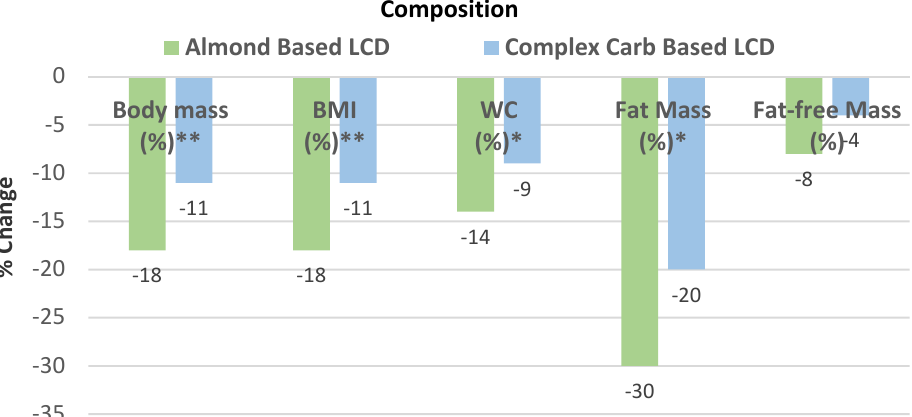
Figure 15. Effect of 1000 kcal almond- and carbohydrate-based LCDs on weight measures from baseline to 24 weeks (** p < 0.0001 and * p < 0.05) [65].